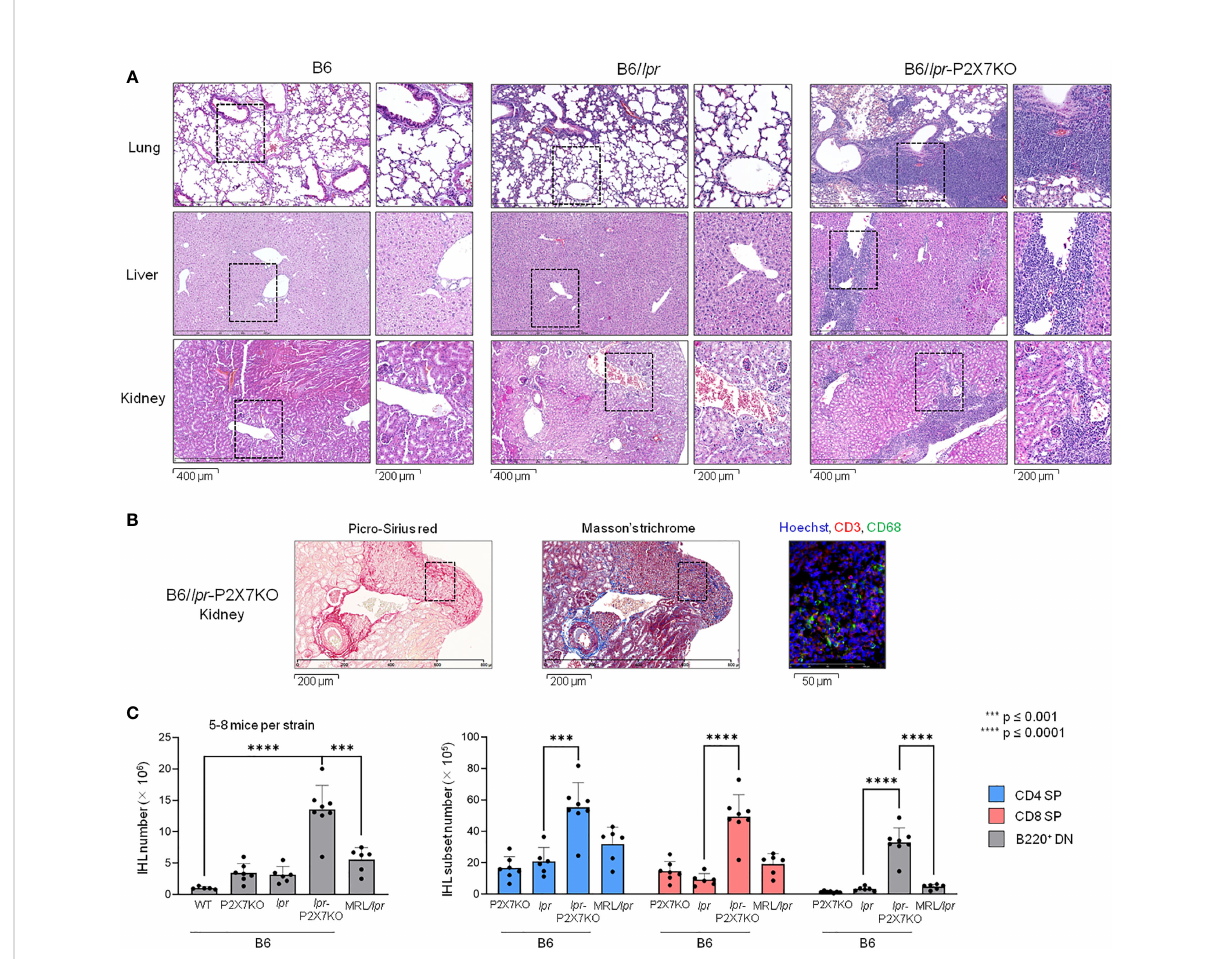
FIGURE 4 Massive leukocyte in fi ltration in the liver, lungs, and kidneys of B6/ lpr - p2x7 KO mice. ( A ) Representative photomicrograph (bar scale = 400 m m) of histological examination of mononuclear cell in fi ltrates in lung, kidney, and liver sections from 6- to 7-month-old female B6, B6/ lpr and B6/ lpr - p2x7 KO mice. The corresponding position of the inset is indicated by a black dotted line in the photomicrographs. The inset photomicrograph (bar scale = 200 µm) is shown in the second column of the panel for each mouse strain and tissue. Histological photomicrographs were captured using a digital camera. (B) Renal tissue sections from B6/ lpr - p2x7 KO mice were labelled with anti-CD68 and anti-CD3 fl uorescent mAbs. Sections were stained with picro-sirius red and Masson ’ s trichrome to detect renal fi brosis. (C) In fi ltrating leukocytes isolated from individual livers of 7- to 8-month-old female B6/ lpr , B6- p2x7 KO and B6/ lpr - p2x7 KO mice and 4-month-old female MRL/ lpr mice were stained with either fl uorescent mAbs against the phenotypic markers CD90, B220, CD4, and CD8 or isotype controls and analyzed by fl ow cytometry. Bar graphs show the mean percentage (SD, n = 5-8 livers per strain) of total CD90 + T cells (IHL, left panel), as well as CD4 + ( ), CD8 + ( ) and B220 + DN ( ) CD90 + T-cell subsets. Each dot in the bar graphs represents an individual mouse. Error bars in graphs show SD. Asterisks above horizontal lines indicate statistically signi fi cant differences assessed with unpaired two-tailed t -test. ***p ≤ 0.001, ****p ≤